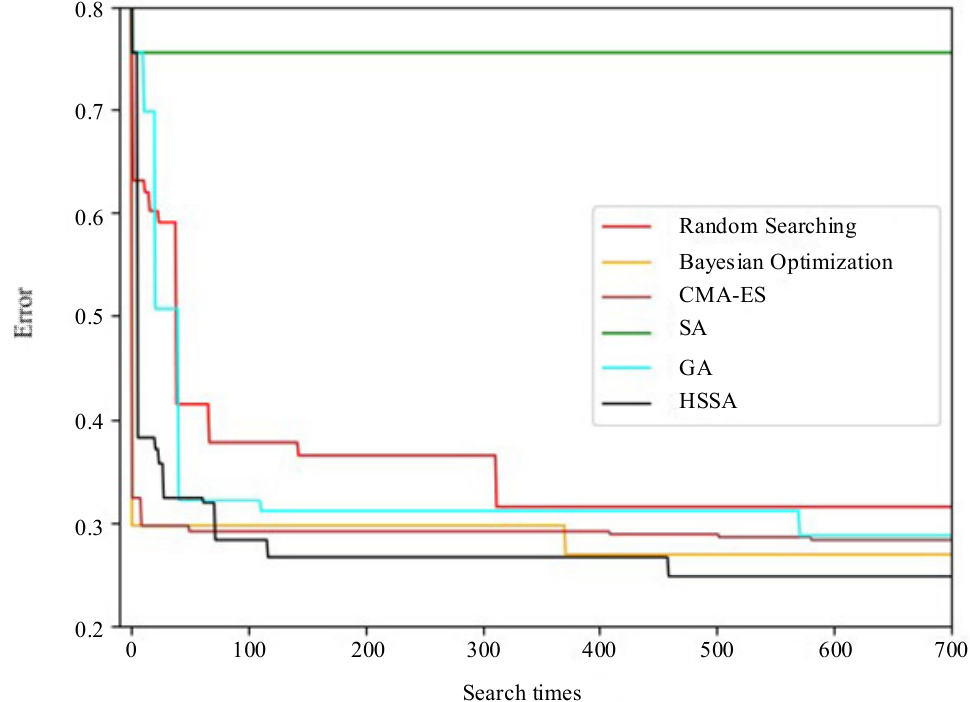
Figure 7. Result of the performance verification experiment on Five Flowers.